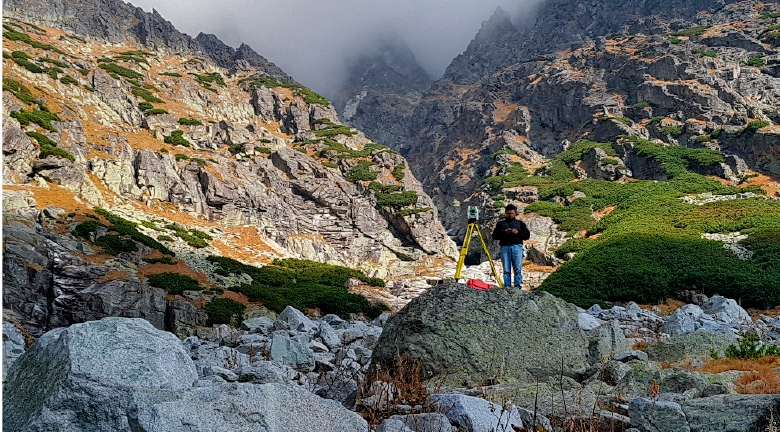
Figure 4. Accumulation zone of the talus cone—detail.